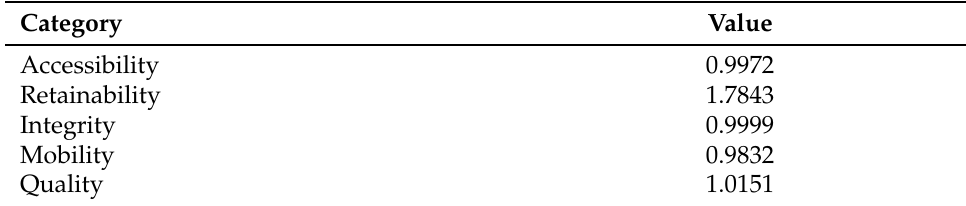
Table 5. Values per category.